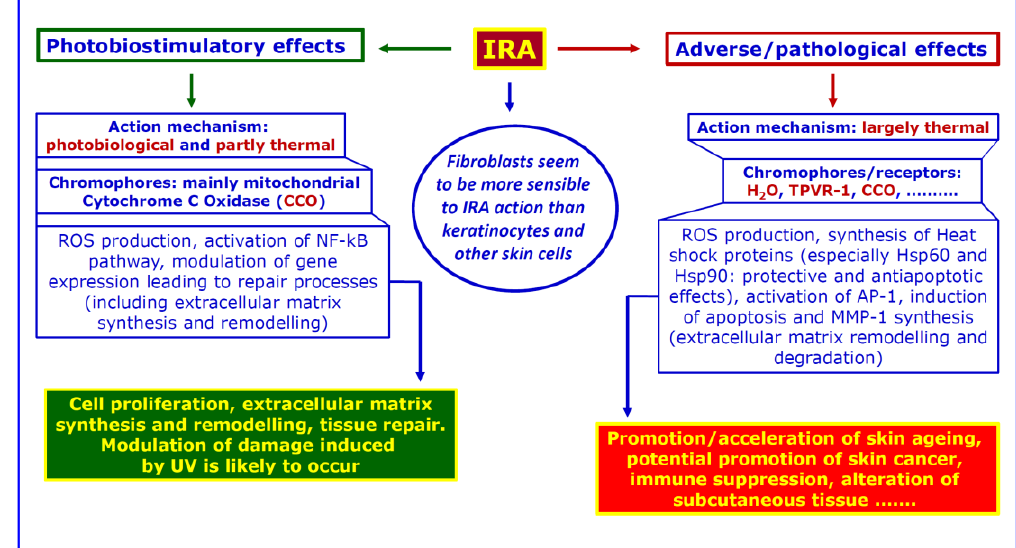
Figure 3. A simplified overview of the biological mechanisms underlying both photobiostimulatory and adverse/pathological effects due to IRA (InfraRed A) exposure, with indication of the possible outcomes. The prevalence of one type of effects over the other one is dependent on spectral composition, total dose, dose-rate, biological target and, possibly, other unknown factors.